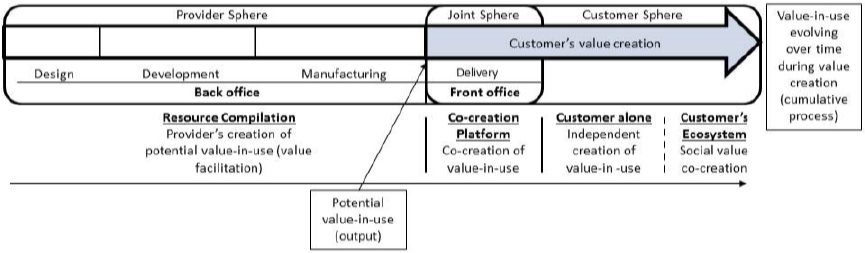
Fig. 1. SL based value generation, process model. Source: Grönroos and Gummerus (2014, p.